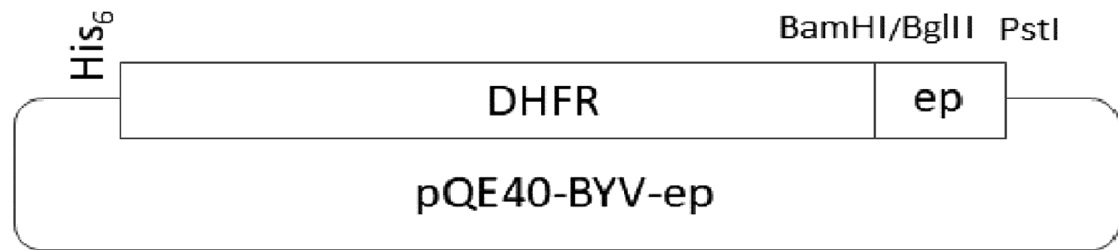
Figure 2. Scheme of the vector that expresses the epitope.